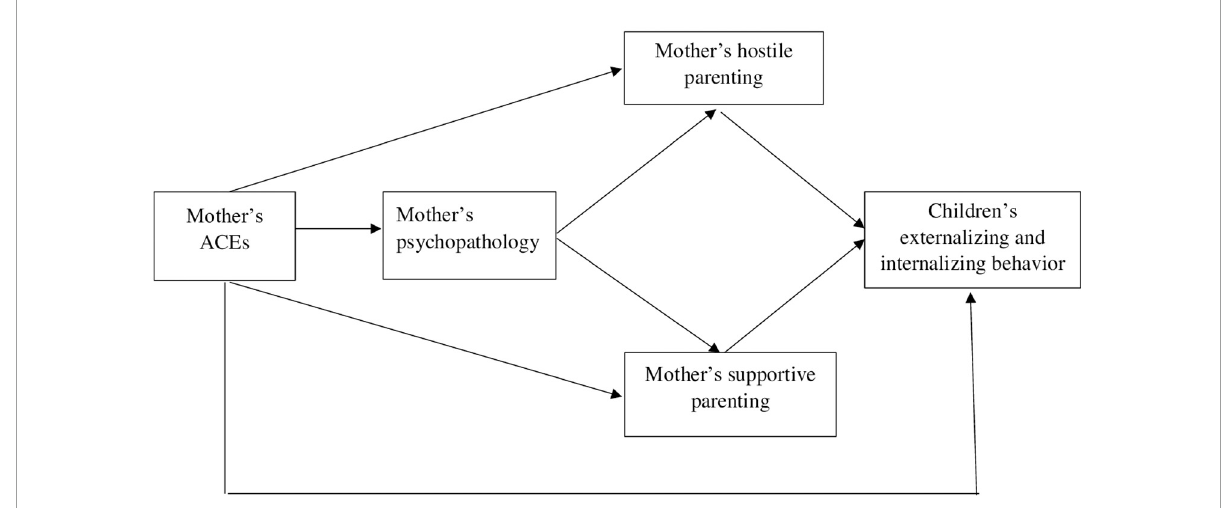
FIGURE1 Theoretical mediation model for the association between the mother’s ACEs and her child’s behavior via the mother’s psychopathology and her hostile or supportive